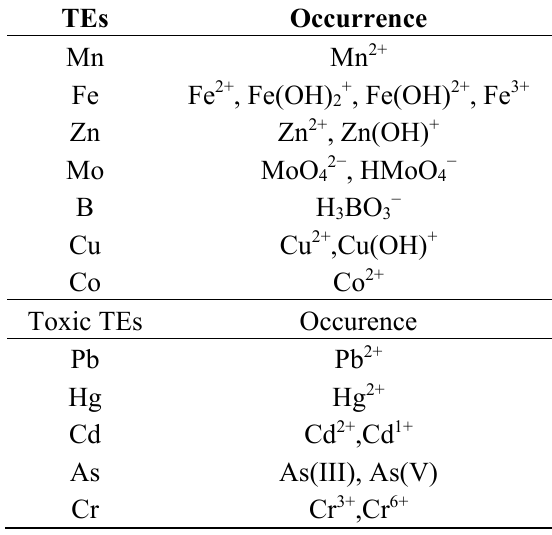
Table 2. Ionic forms of major TEs and toxic TEs in the soil